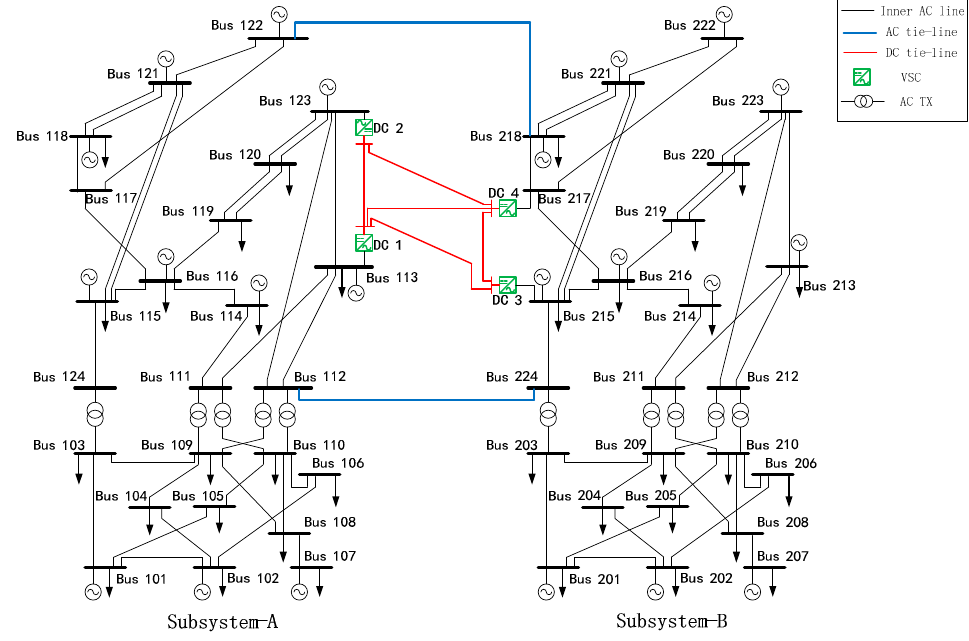
Figure 4. MRTS system with a 4-terminal VSC-MTDC network. Table 1. Impedance information of AC tie-lines.